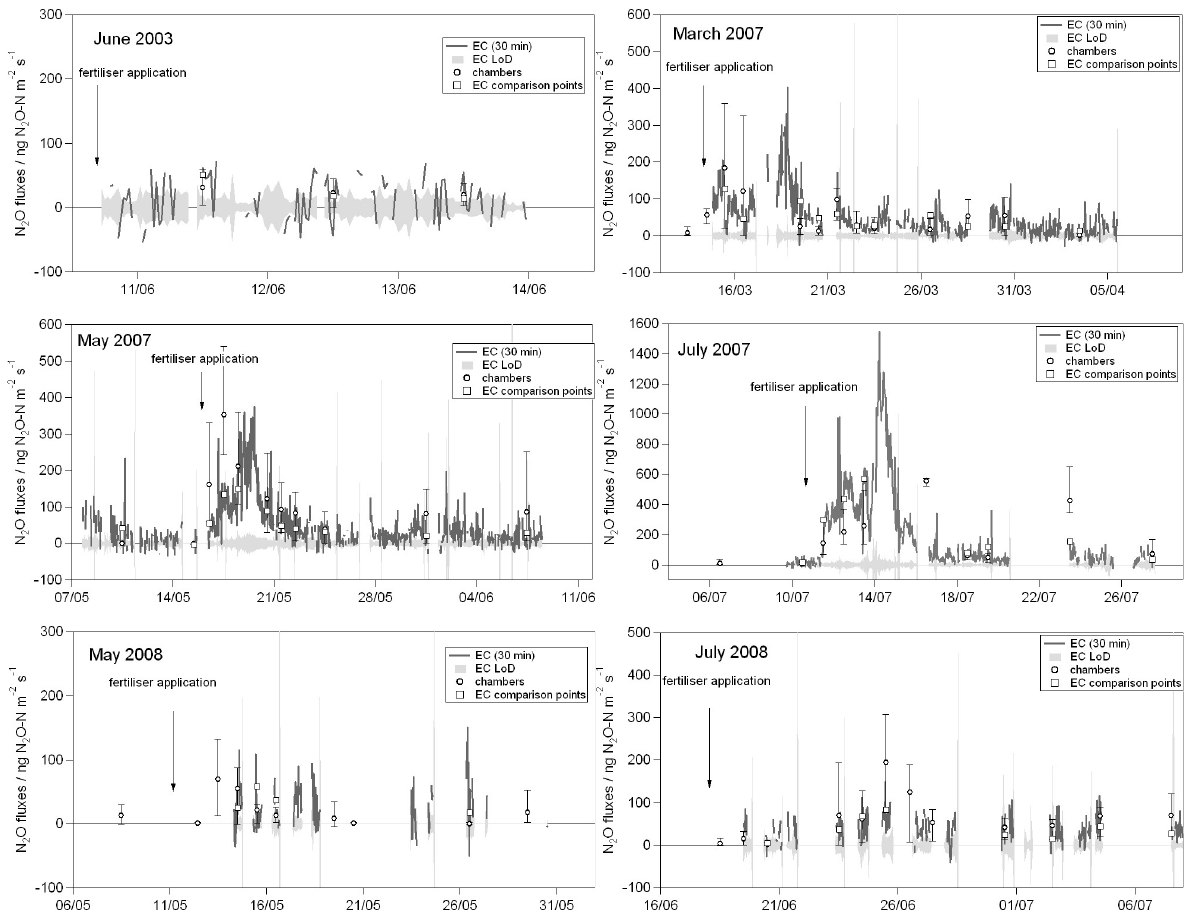
Fig. 2. N 2 O fluxes obtained with eddy covariance and static chambers for 6 comparison periods; eddy covariance data are 30min values (grey line) or values averaged over the one hour period when chambers were closed (between 10:00–12:00, squares). Chamber measurement points represent the average of 14 (2003) or 4 (2007/2008) chambers measured over 1h (white circles), with error bars representing the range of chamber measurements. Fertiliser applications are indicated with an